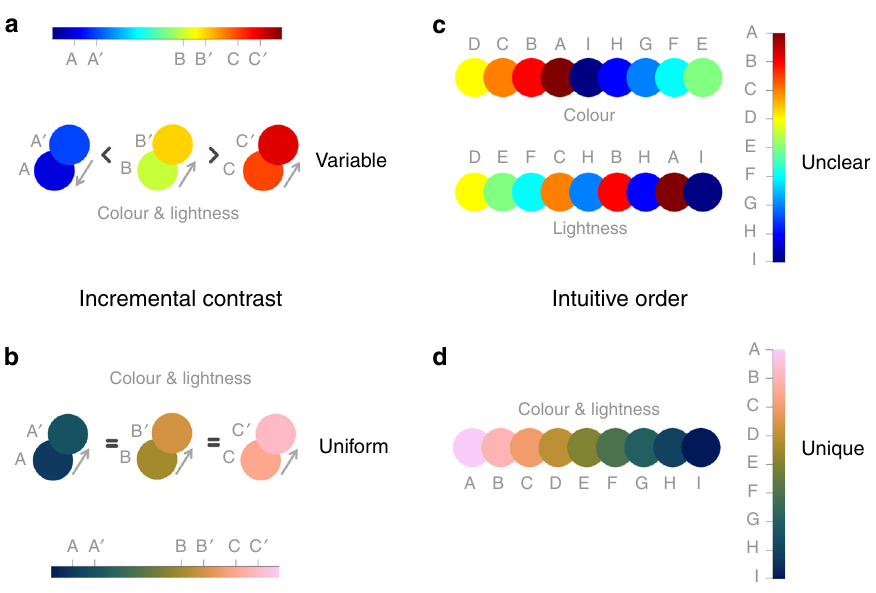
Fig. 4 Perceptual uniformity and order. A constant incremental colour and lightness contrast along a colour map is a proxy for its perceptual uniformity. a While a certain incremental data variation is either under- or strongly overrepresented with jet (a.k.a. rainbow) depending on the colour map segment, it is instead b evenly represented all along a colour bar when using a scienti fi c colour map like batlow 41 , due to its uniform colour and lightness contrast. Perceptual order is given when individual colours of a colour map can be sequentially ordered effortlessly without consulting the colour bar. While c a sequential ordering is not intuitively possible for jet (a.k.a. rainbow), it is d possible to sequentially order individual colours of a scienti fi cally derived colour map like batlow 41 , thanks to its constant lightness gradient.